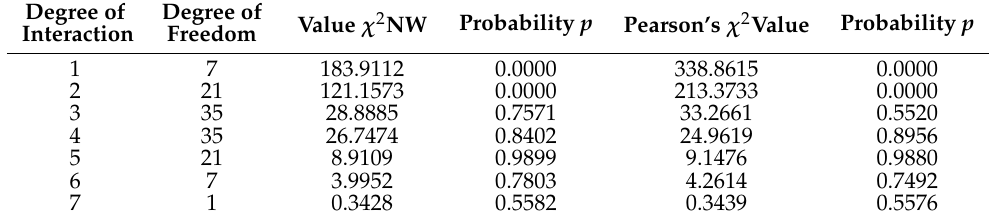
Table 6. The results of variable interaction tests.